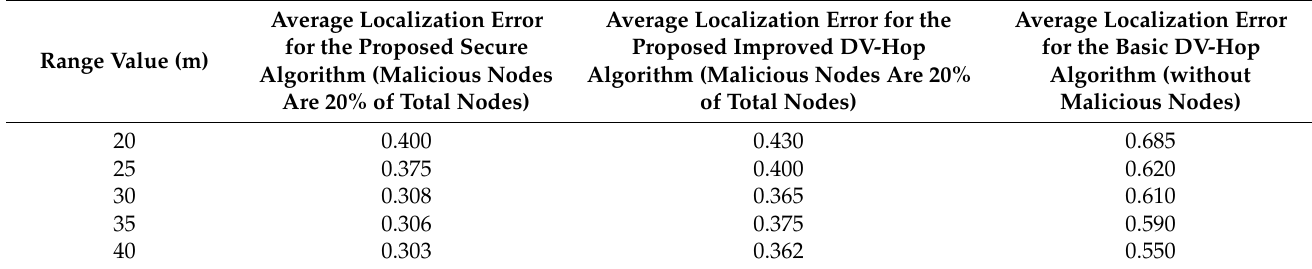
Figure 11. Variation of error by range. Table 8. Average localization error variation corresponding to the range value with and without malicious nodes for the proposed algorithm and other variants.